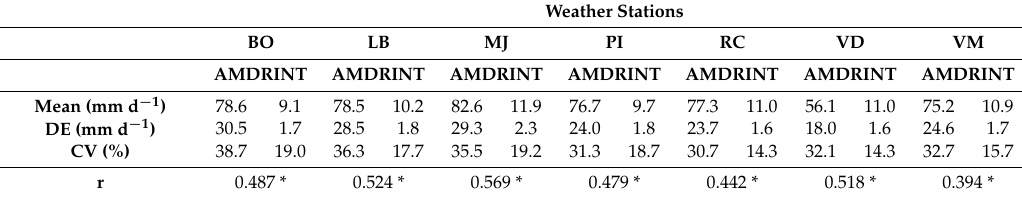
Table 1. Position (mean) and dispersion statistics (DE: standard deviation; CV: coefficient of variation (DE/mean)) of the annual maximum precipitation in 24 h (AMDR) and the mean annual intensity (INT) for different weather stations of C ó rdoba, Argentina, over the period 1960–2012, with the coefficient of correlation (r) between